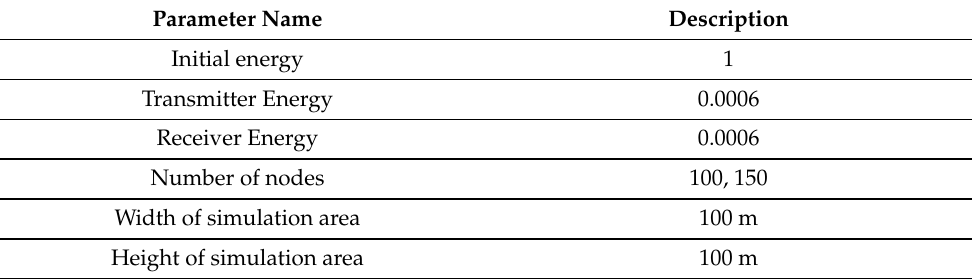
Table 2. Parameters utilized for the experimentation.